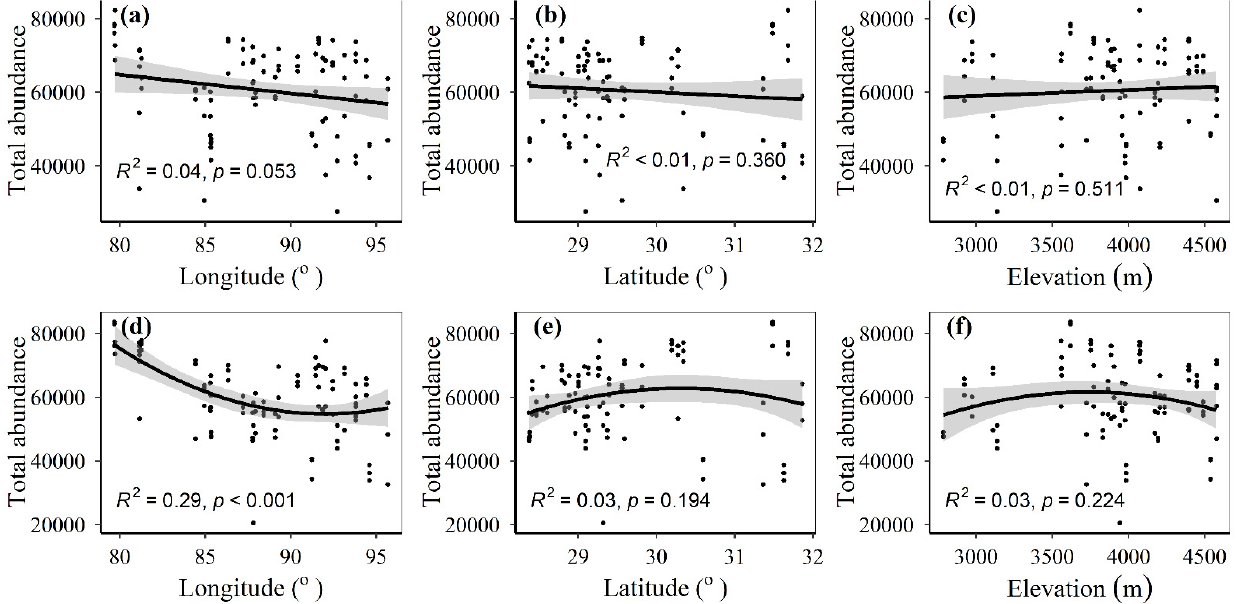
Figure A10. Relationships between total abundance and geographic variables (longitude, latitude,